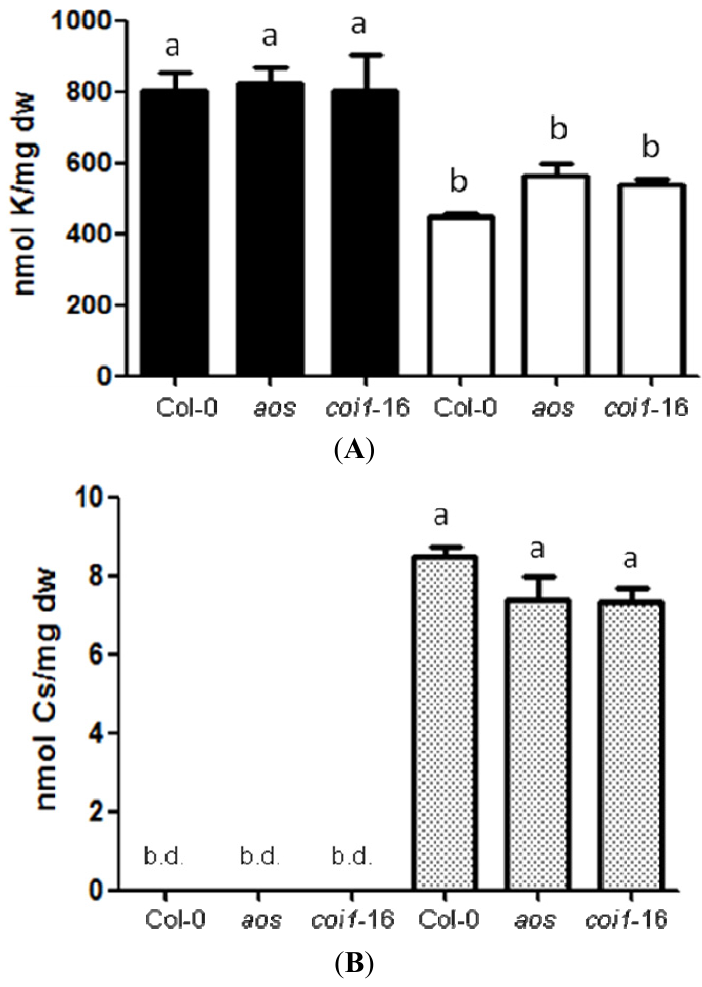
Figure 2. ( A ) K + contents in Col-0, aos and coi1 -16 grown on 1.75 mM KCl with (white bars) or without (black bars) 0.3 mM CsCl for seven days. ( B ) Cs + contents in Col-0, aos and coi1 -16 grown on 1.75 mM KCl with (dotted bars) or without 0.3 mM CsCl for seven days. Error bars indicate standard error for four biological replicates. Each sample contained more than 15 seedlings. b.d.: below the detection limit. Alphabetical letters show statistical differences ( p <